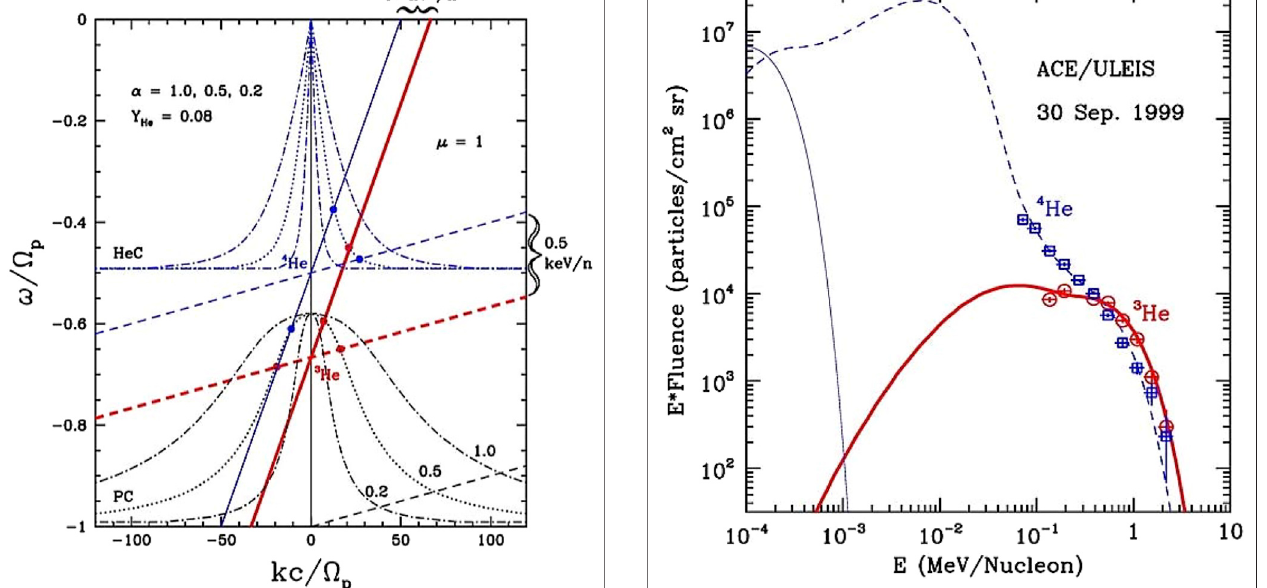
FIGURE 6 | Resonant interactions of Helium 3 and 4 with plasma waves in different background plasmas indicated with α , the ratio of the electron plasma frequency to gyro-frequency (Liu et al., 2006). The straight lines stand for resonance conditions for helium isotopes with different energies. The proton gyro-frequency is given by Ω p .